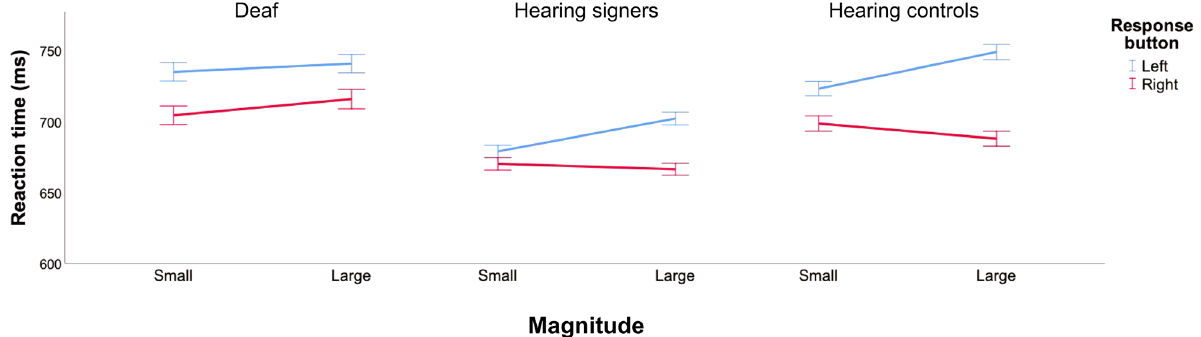
Figure 2. Mean reaction times for deaf (left graph), hearing signers (middle graph) and hearing controls (right graph) in the parity judgment task. Error bars represent the standard error of the means. Untransformed reaction times are represented in the graph for the ease of